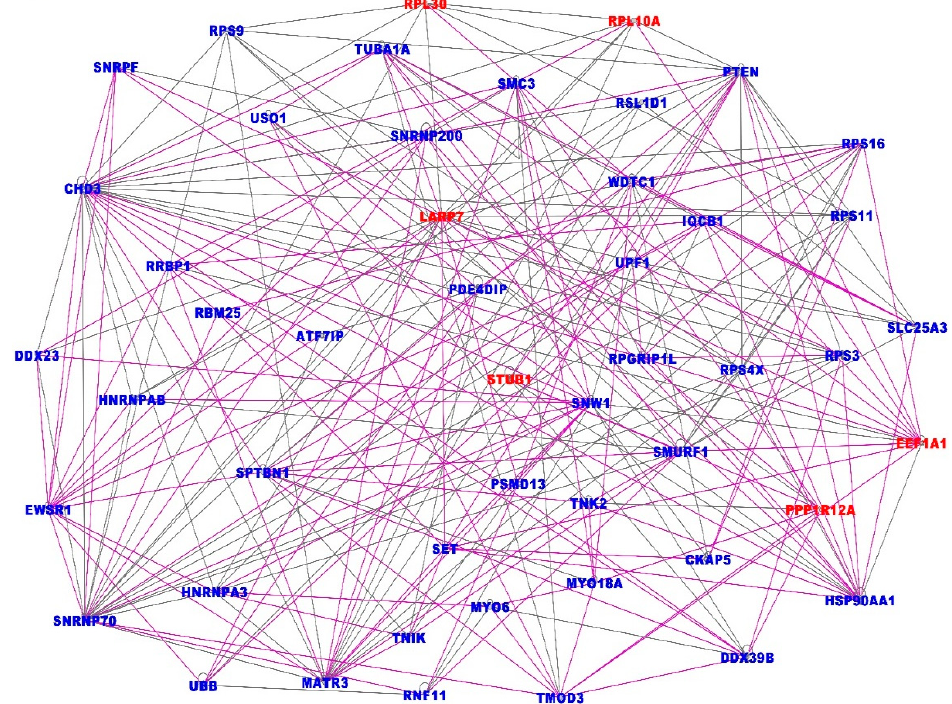
Figure 4. Highly interconnected gene regulatory networks associated with both COVID-19 and lung cancer. The gene names in red font indicate upregulation and blue font downregulation. The solid lines indicate overlapping functions between the genes in the seven merged networks.